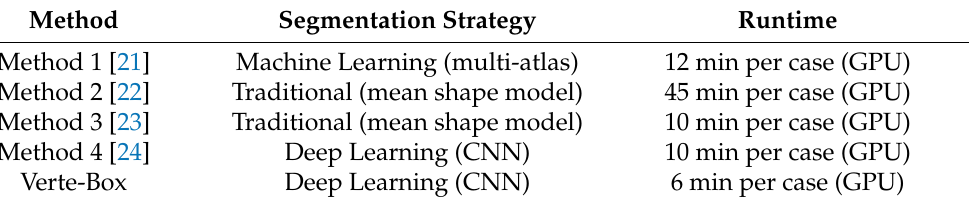
Table 5. Comparison with participating